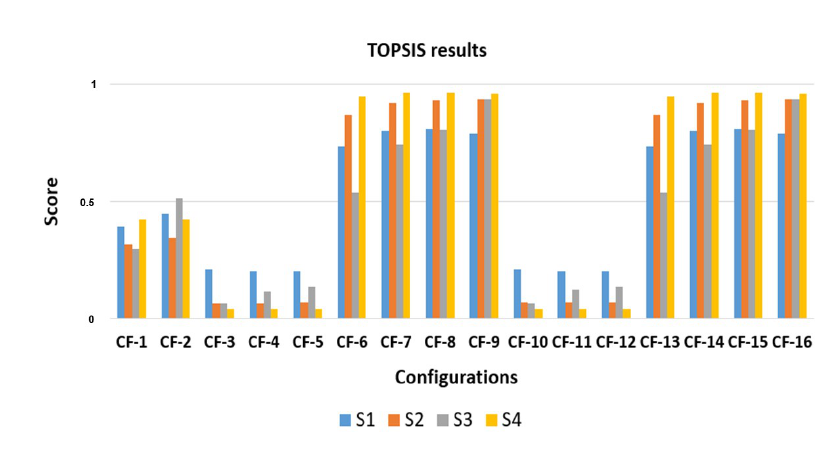
Figure 9. Illustrative results obtained by TOPSIS